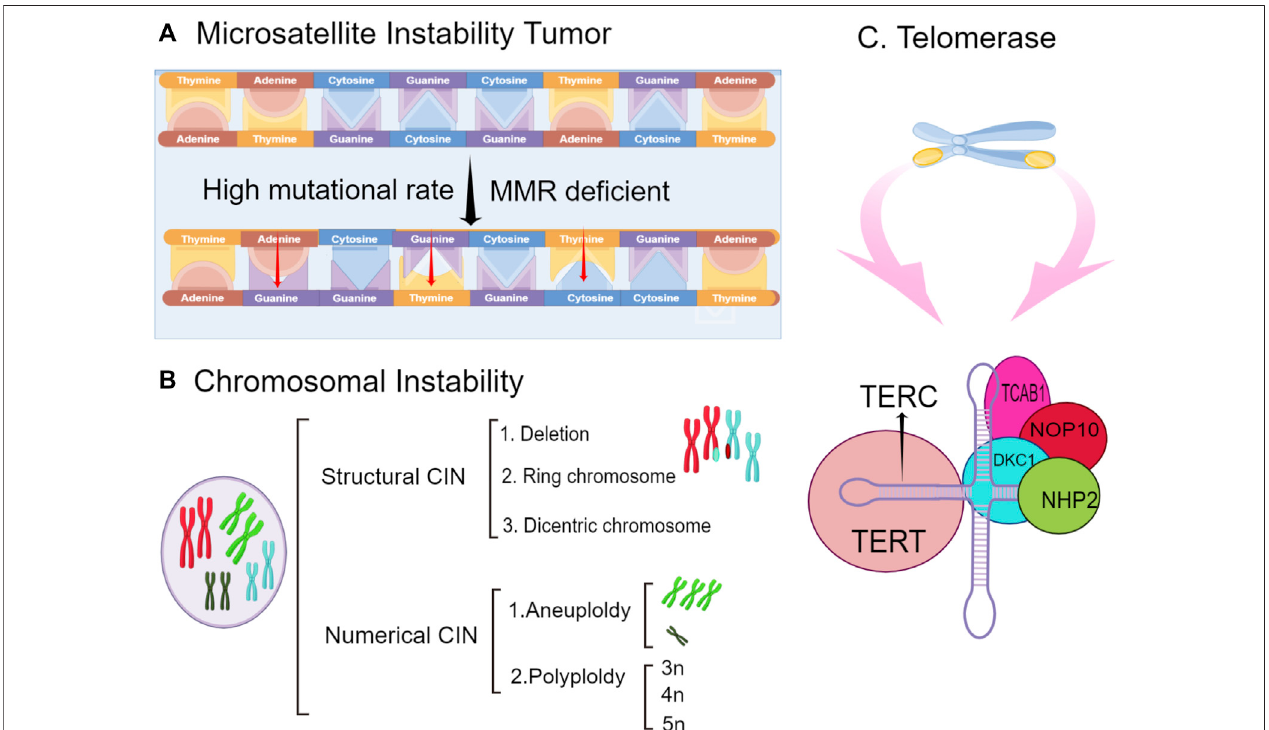
FIGURE3| Thetypesofgenomicinstabilityincludemicrosatelliteinstability(MSI),chromosomalinstability,andtelomeraseinactivation. (A) .tumorigenesisbecause of MSI is caused by the abnormal regulation of the expression of target genes (B) . chromosomes undergo structural or numerical changes, such as deletions and exchanges and aneuploidy and polyploidy, respectively. (C) . telomerase inactivation on chromosomes can lead to genomic instability and gastric cancer. The structure of telomerase is shown.